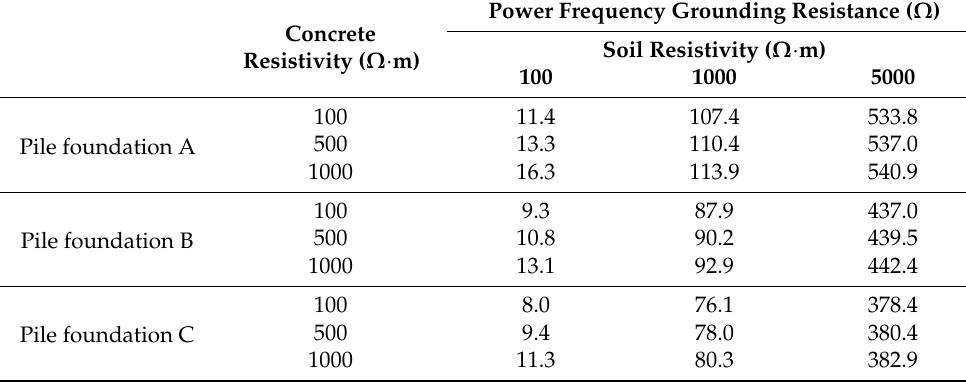
Table 3. Power frequency grounding resistances under different conditions in the method of this paper.